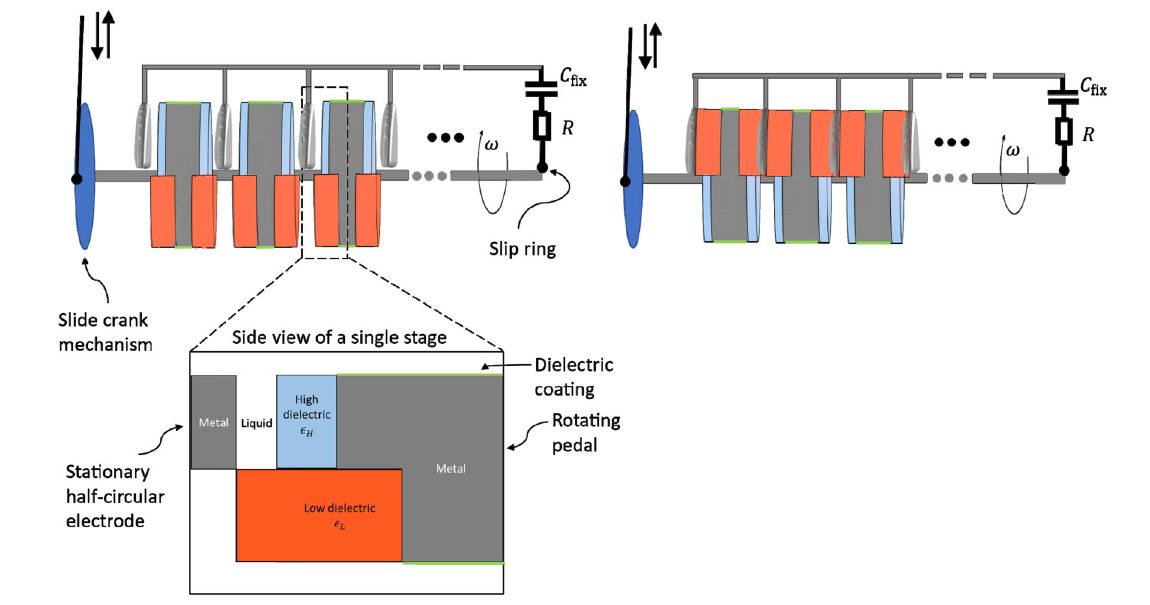
Fig. 1 | Modi fi ed rotor design for operation in ionic liquid. Left and right panels show the rotor at different rotational phases, that of maximum and that of mini- mum capacitance correspondingly. Stationary electrodes are designed to have